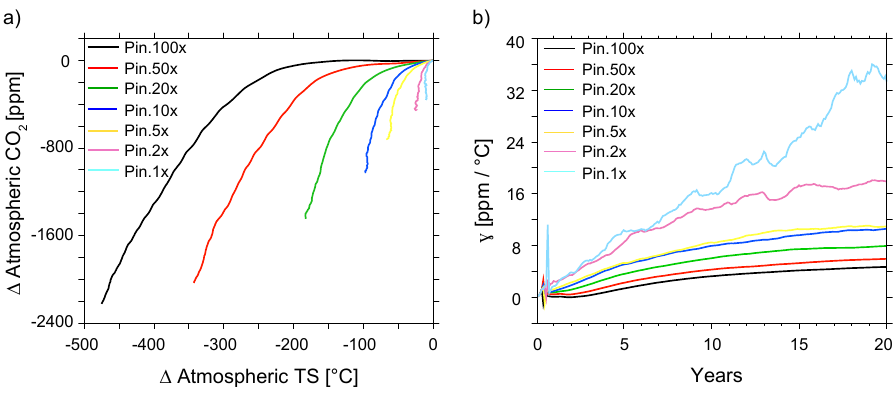
Fig. 3. (a) Simulated cumulative temporal mean changes in atmospheric CO 2 vs. temporal mean changes in atmospheric surface temperature for different Pinatubo scalings. The point values leading to the curves are time integrals of the data in Fig. 1c and d. Note that the ratio of the cumulative values equals the ratio of time averaged values and thus climate-carbon sensitivity γ defined by Eq. (5) and shown in panel b; the larger the slope of the curve the larger γ . (b) Time-series of estimates of the climate-carbon cycle sensitivity γ derived from the Pinatubo scaling experiments.